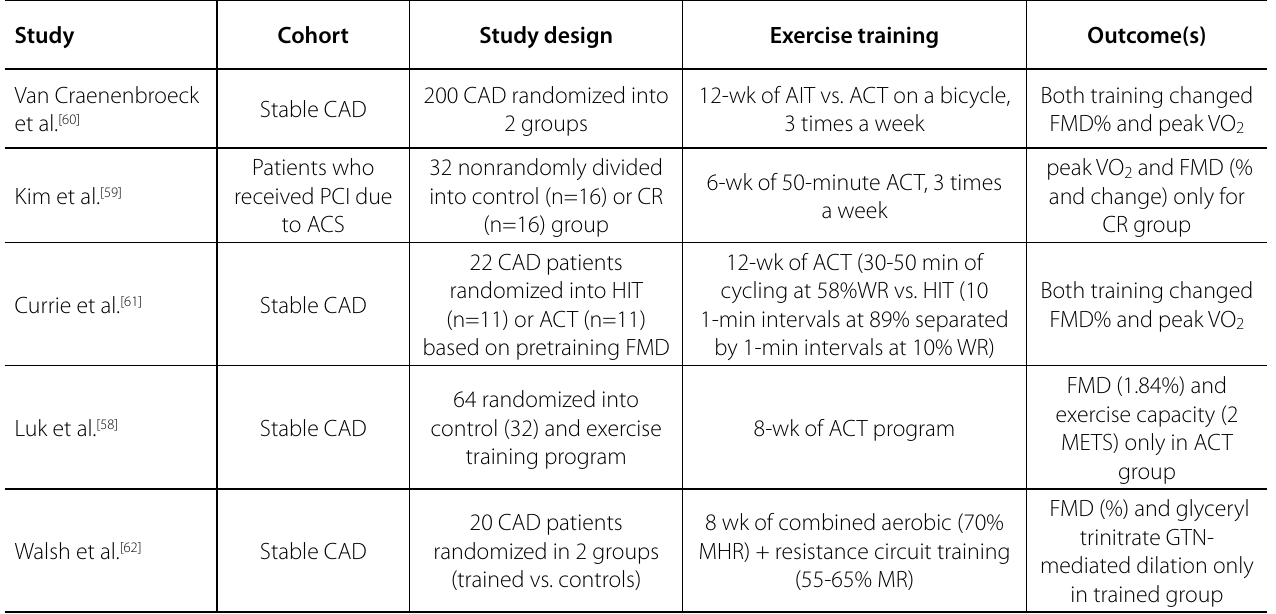
Table 2. Summary of exercise training studies assessing change in FMD in coronary arterial disease patients.